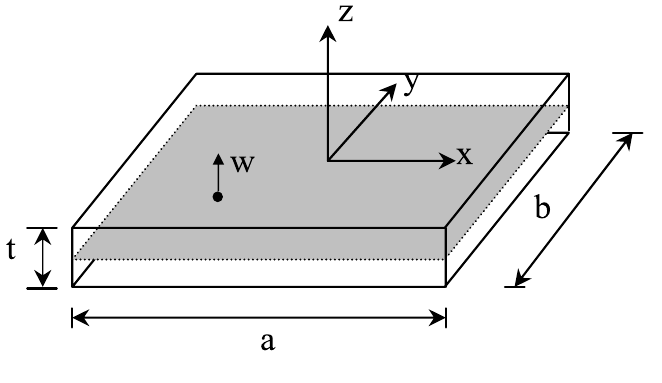
Fig. 1. The sample plate used in this